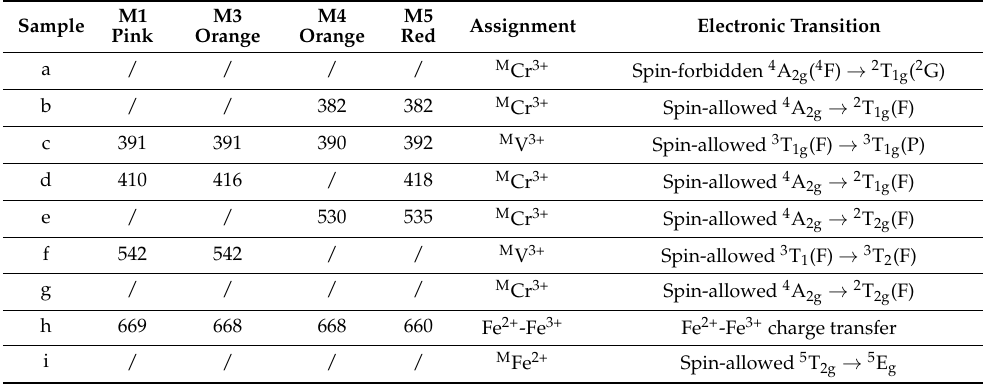
Figure 7. Band analysis of UV-Vis spectra of M3 ( a ), M5 ( b ), M2 ( c ) and M6 ( d ). Table 3. UV-Vis spectral peak positions of the red series samples M1 M3 M4 M5